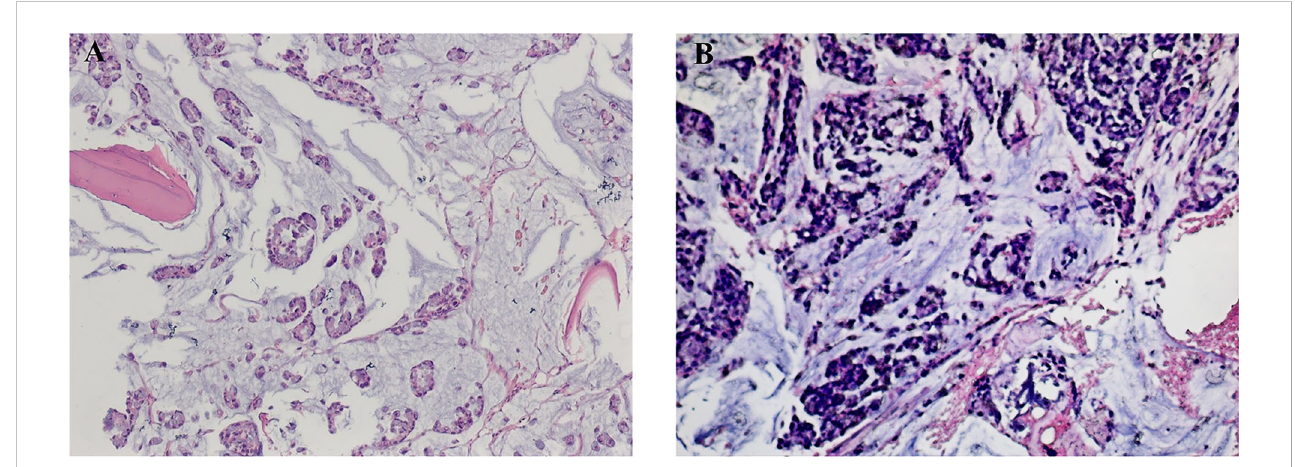
FIGURE 1 The results of a bone marrow biopsy pre- and post-treatment (H&E). (A) The pre-treatment bone marrow biopsy revealed metastatic adenocarcinoma with mucinous features. (B) The post-treatment bone marrow biopsy also shows metastatic adenocarcinoma.